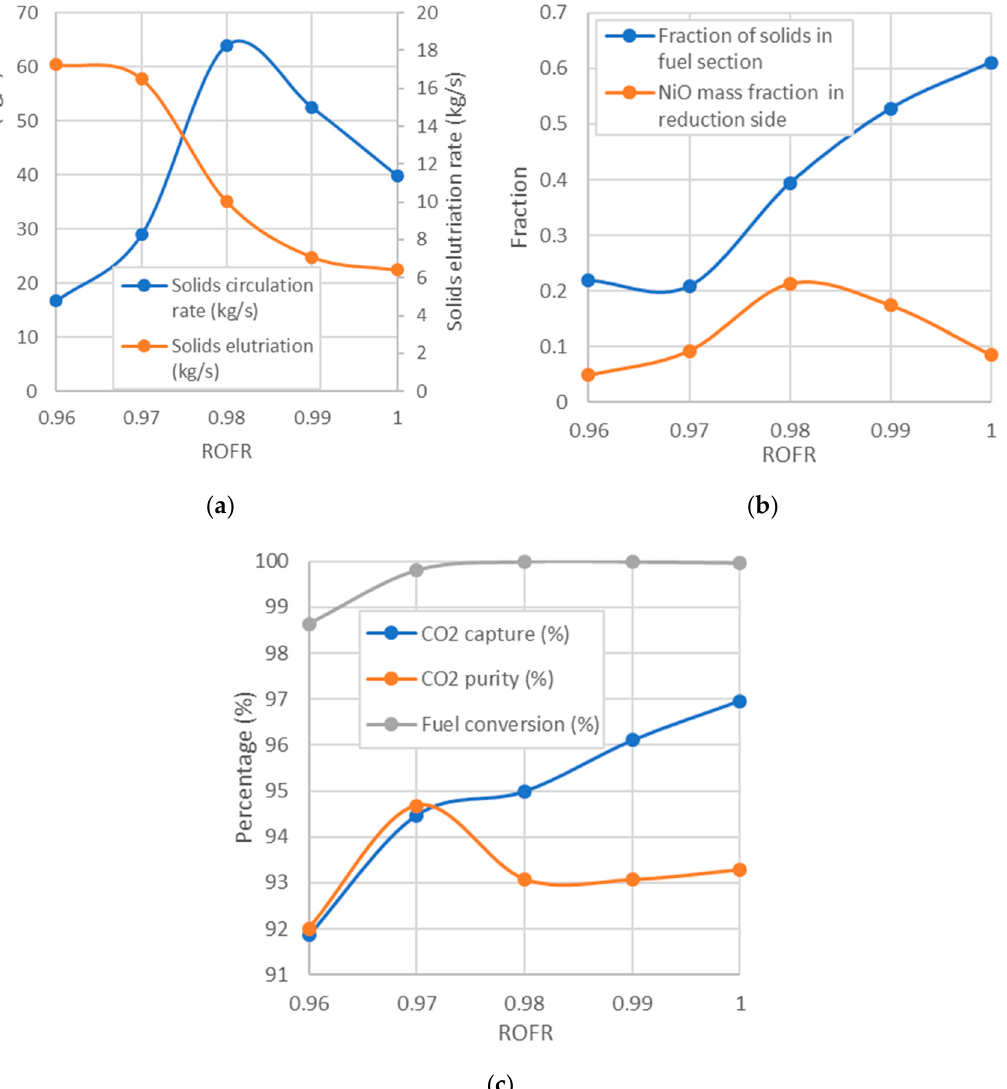
Figure 8. Summary of important time-averaged properties of the ICR as a function of the reduction outlet flow ratio: ( a ) solids circulation and elutriation rates; ( b ) fraction of solids and NiO mass fraction in the reduction side; ( c ) CO 2 capture, CO 2 purity (molar percentage on a dry basis), and fuel conversion.